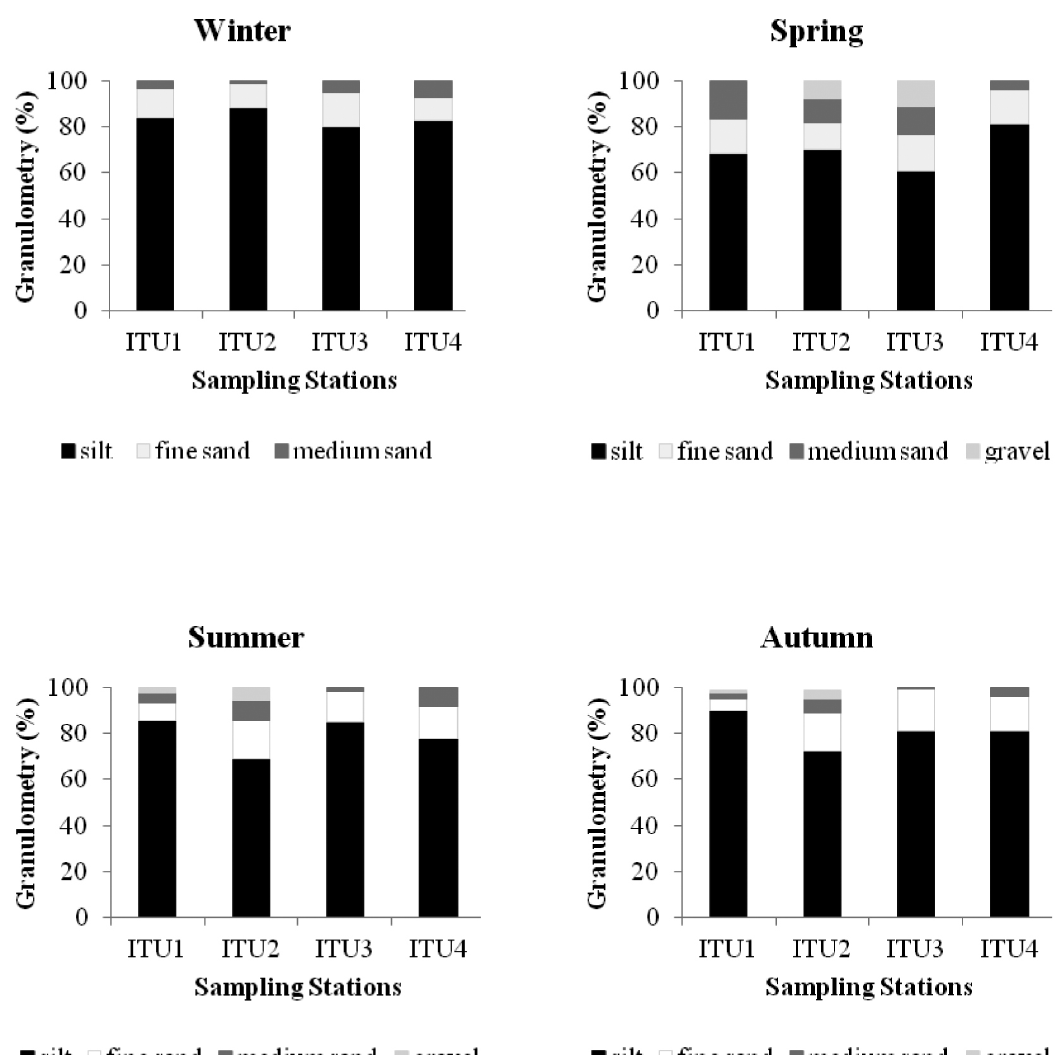
Figure 5. Granulometric fractions in different arms and seasons in Itupararanga